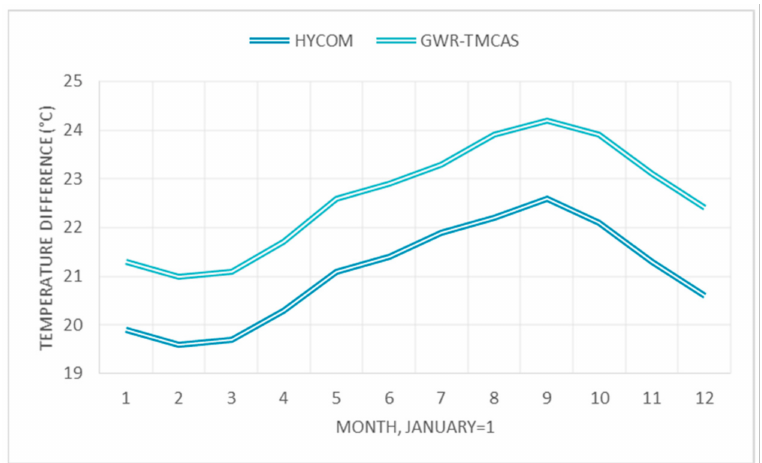
Figure 4. Temperature difference between 0 and 700 m depth of Hybrid Coordinate Ocean Model (HYCOM) and Geographically Weighted Regression Temperature Model for the Mexican Caribbean Sea (GWR-TMCAS) in the study area along the